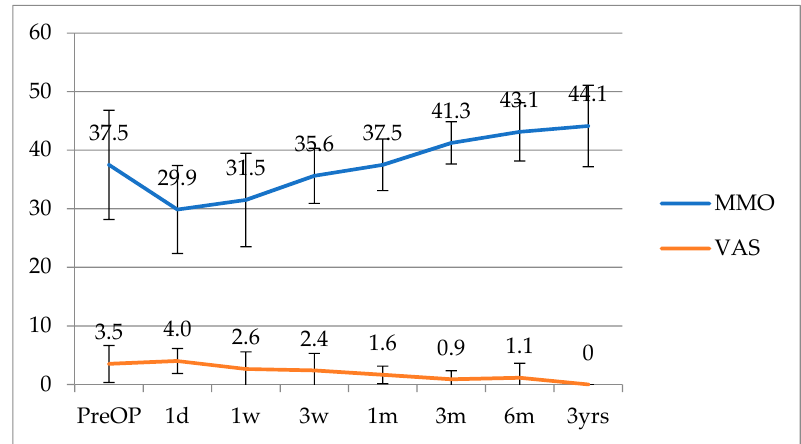
Figure 3. Consistent tendency of change in MMO and pain score (VAS). No significant complications were observed by radiographic images and clinical exams in any operated joints within the follow-up periods. All natural joint sides were also stable and no functional disabilities were observed with minimal remodeling (Figure 4).